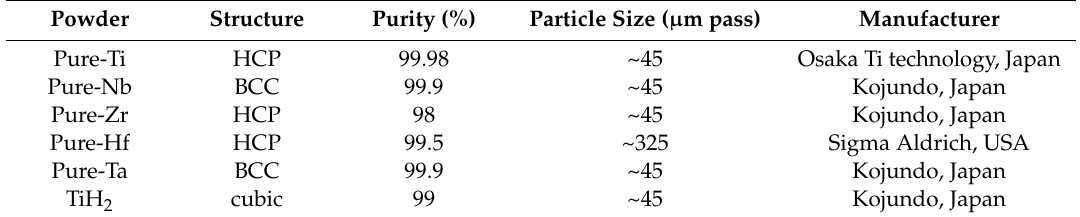
Table 1. Purity, particle size, and manufacturer of the starting powder materials.